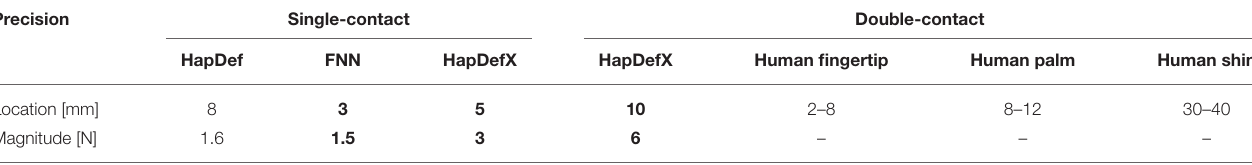
TABLE 2 | Prediction accuracy summary: comparison of the prediction performance of HapDefX, HapDef and Human skin.